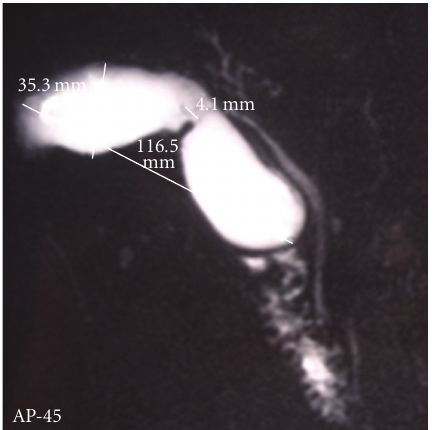
Figure 2: MRI findings. The cystic duct was not seen. Figure 3: Perioperative view showing a true duplication of the gallbladder.